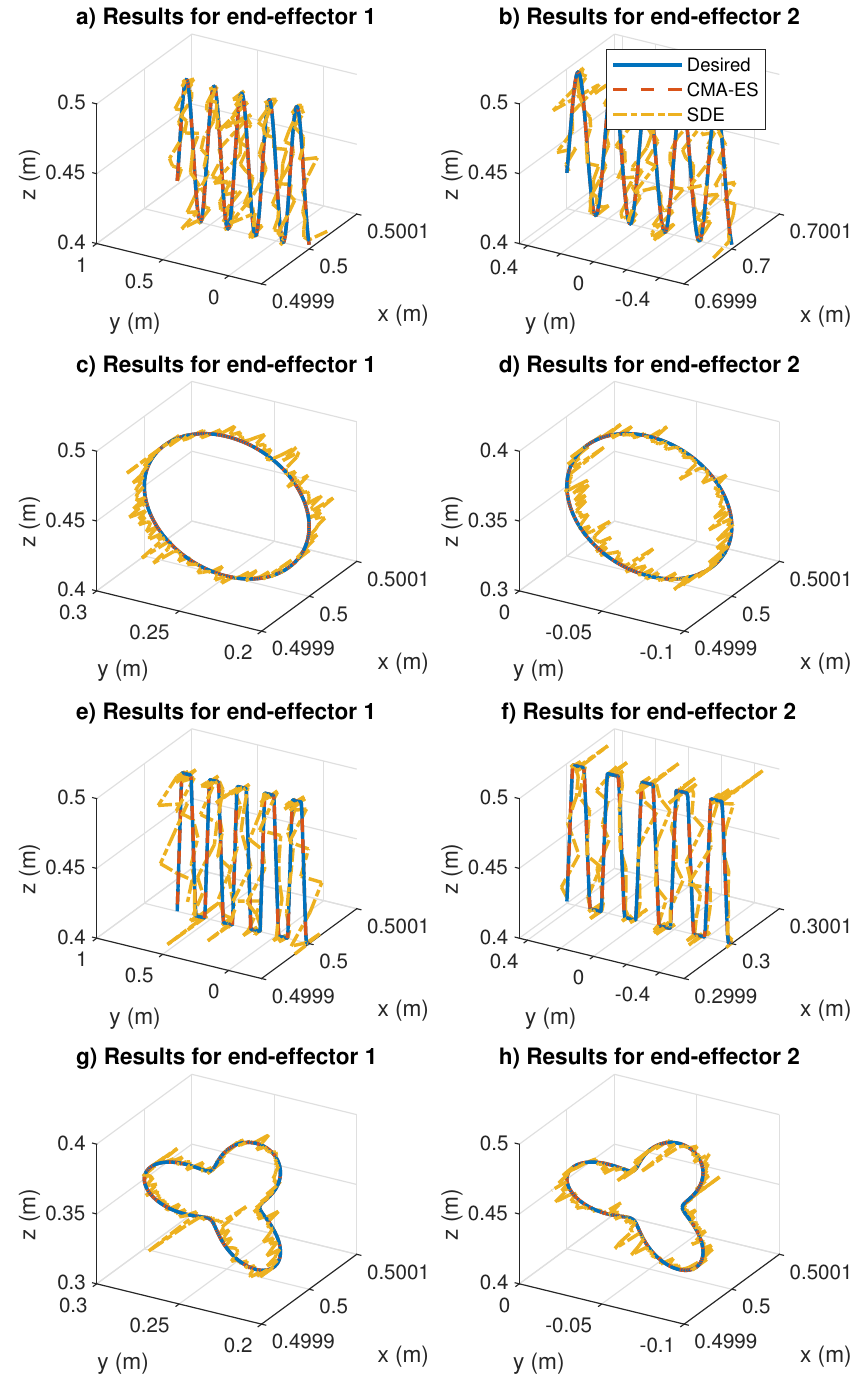
Figure 8. Coordinated trajectory tracking comparative results. The compared algorithms are CMA-ES and SDE. The “Desired” label means the desired end-effector